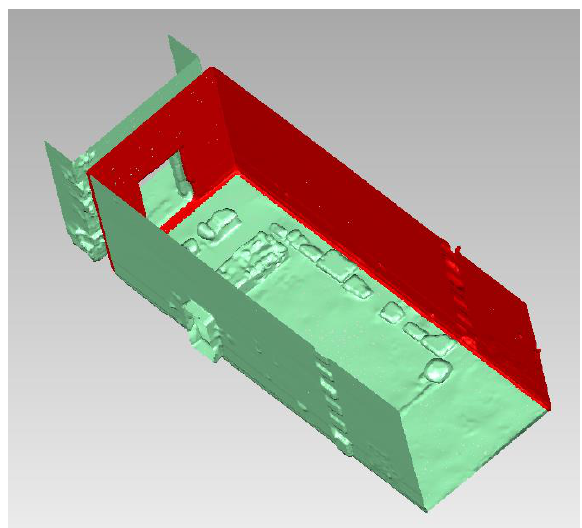
Figure 9. Displaying in red the two planes to apply the edge detection process After completion of the procedure, a deviation of the edge from Figure 11. a) Planes and b) edge imaging in two the two planes was observed. In particular, the deviation appeared from the middle of the edge with its highest value being at its upper end. The highest deviation value was 4 cm.